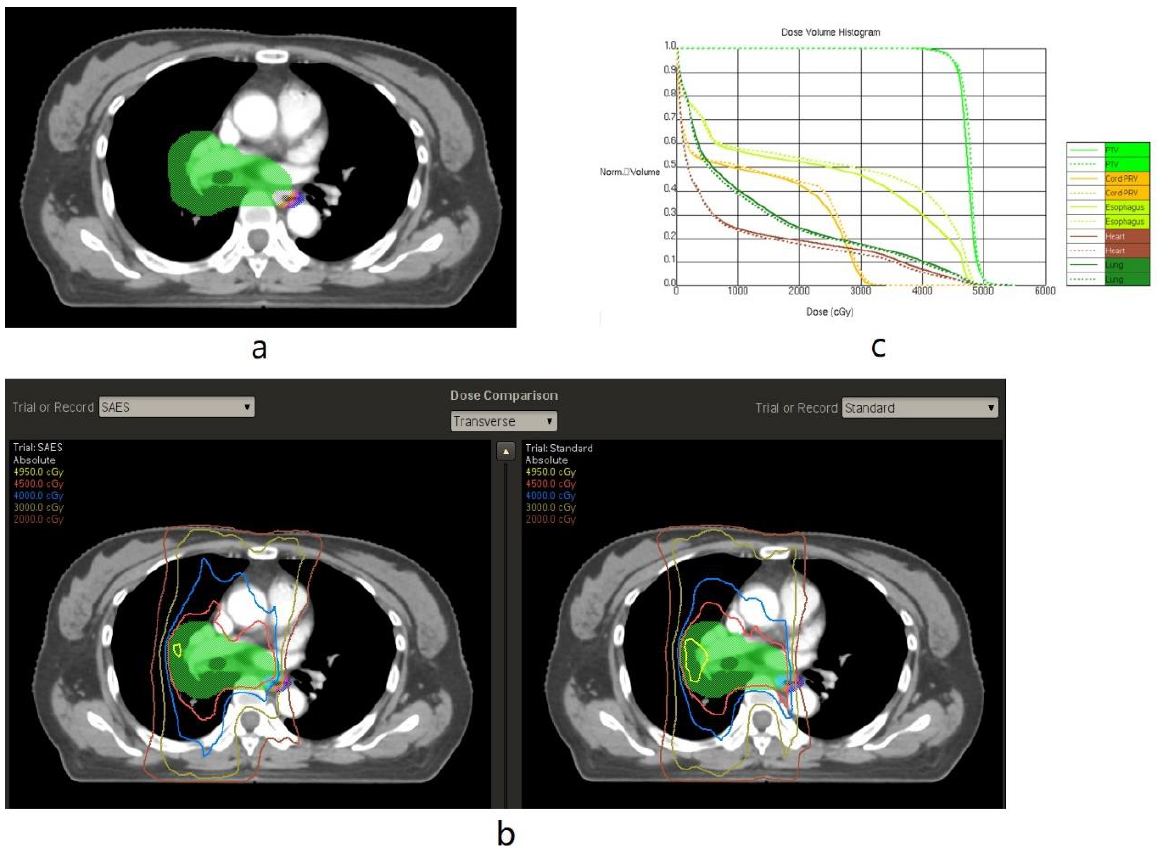
Figure 3. Illustrating the segmental abutting esophagus-sparing technique applied in right-side tumour (Axial CT Images). ( a ): Examples of planning target volume (green), involved esophagus (IE, white), abutting esophagus1 (AE1, orange), AE2 (light purple), and AE3 (shaded blue). In the SAES plan, an isodose line of 4000 cGy was set to avoid AE1–3, and an isodose line of 3000 cGy was set to avoid AE3. ( b ): Examples of isodose line distributions showing effective AE-sparing sparing in the SAES plan compared to the standard (non-SAES) plan. ( c ): Examples of dose-volume histogram (DVH) showing reduced volume of the esophagus receiving 30–45 Gy in the SAES plan (solid line) compared with the standard plan (dotted line).